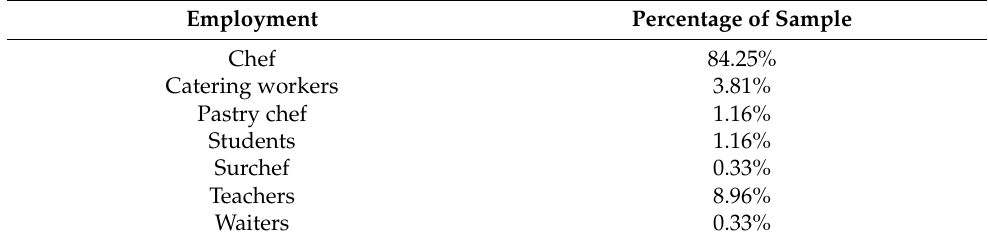
Table 1. Occupation of the sample (N = 603).